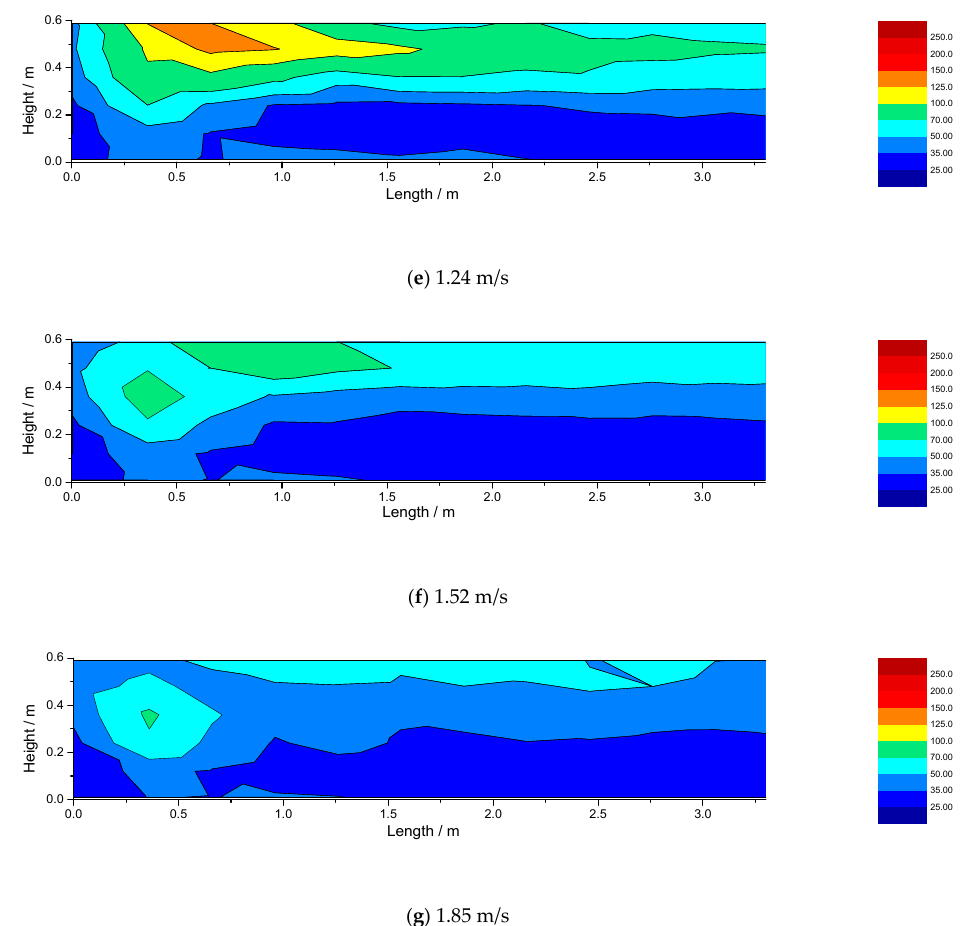
Figure 5. The temperature profile for the heat release rate (HRR) of 20 kW (fully open to the environment).